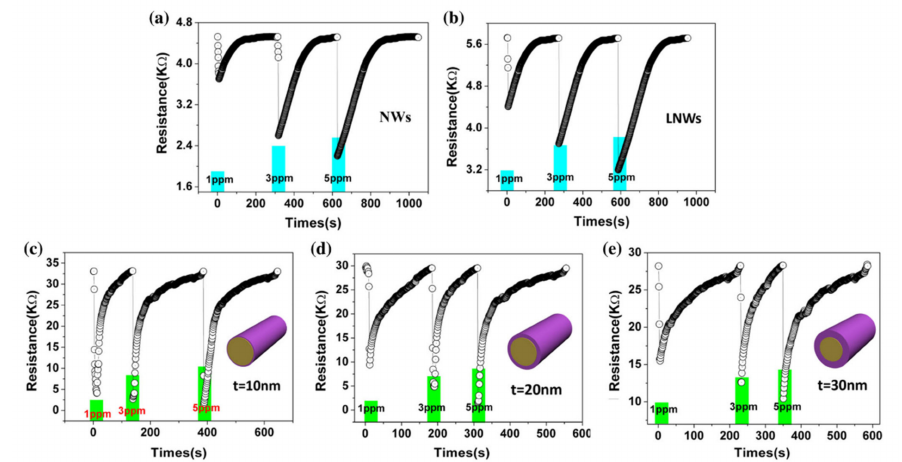
Figure 25. Dynamic response of the sensors based on NWs: ( a ) LNWs, ( b ) LNWs / PPy-10, ( c ) LNWs / PPy-20 ( d ), and LNWs / PPy-30, and ( e ) to varying concentration of NO 2 at room temperature. Reproduced from [117], with permission from John Wiley and Sons, 2020.